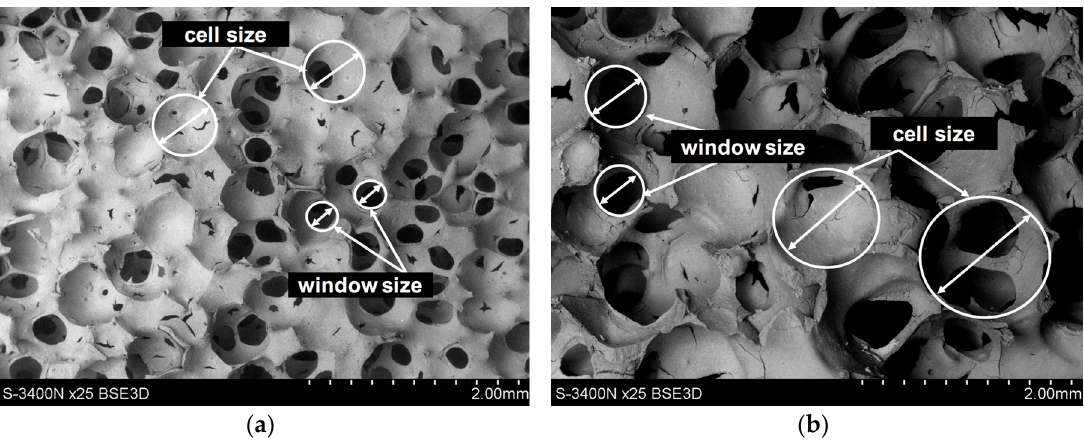
Figure 1. Scanning electron microscopy (SEM) micrographs of alumina oxide preforms used for centrifugal infiltration process by liquid AlSi alloy: ( a ) Al 2 O 3 _1; ( b ) Al 2 O 3 _2.